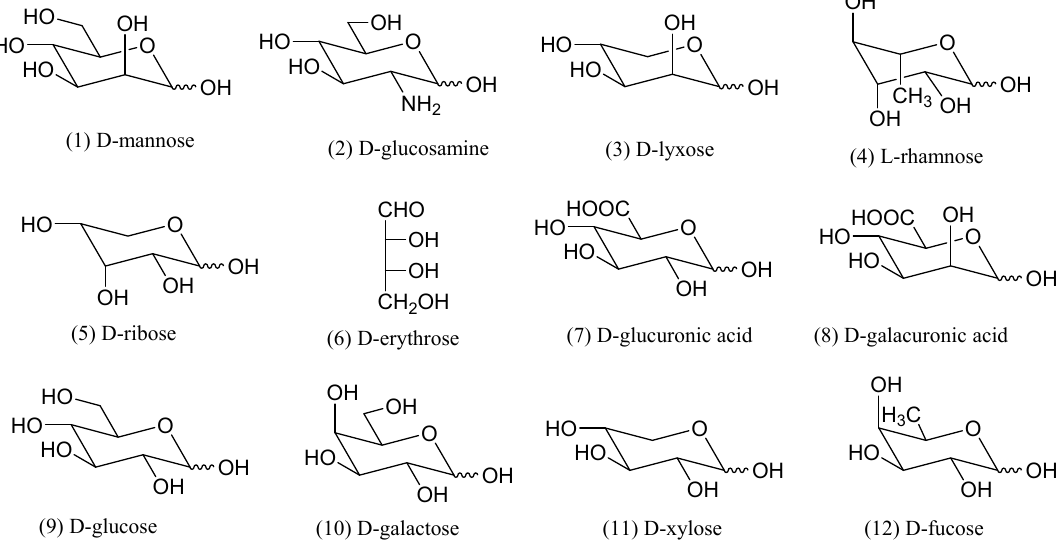
Figure2. Chemicalstructuresof12monosaccharidesidentifiedfrom Polyporusumbellatus polysaccharide